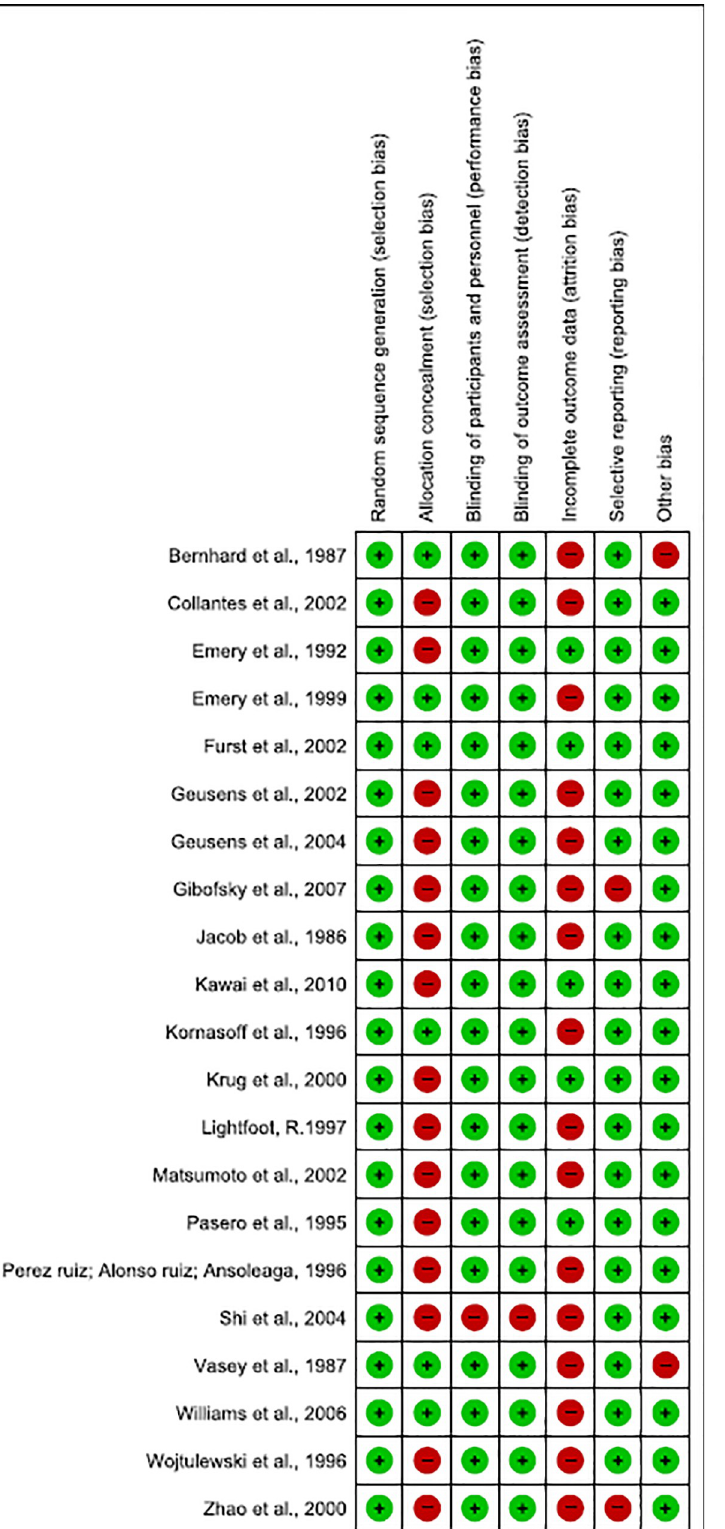
PLOS ONE | https://doi.org/10.1371/journal.pone.0248866 April 7,